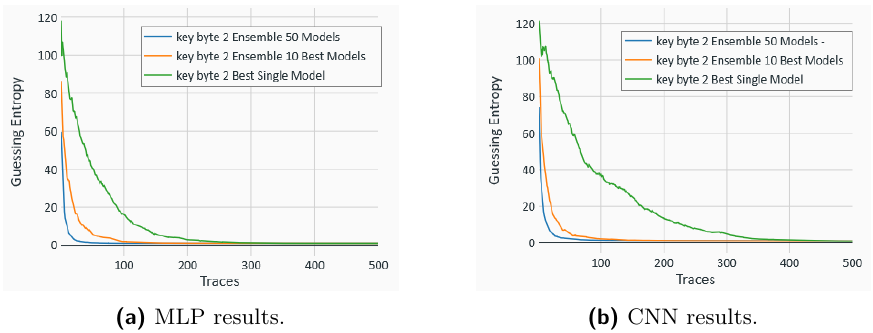
Figure 10: Guessing entropy for ASCAD for the Hamming weight leakage